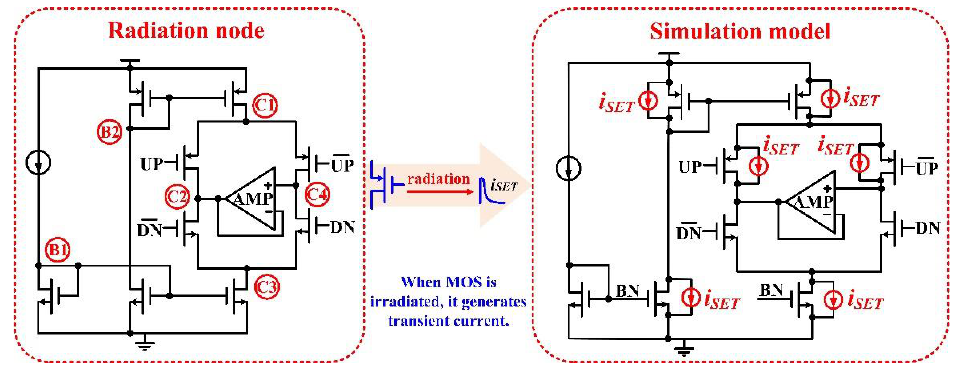
Figure 4. SET circuit level simulation for different nodes of the CP.